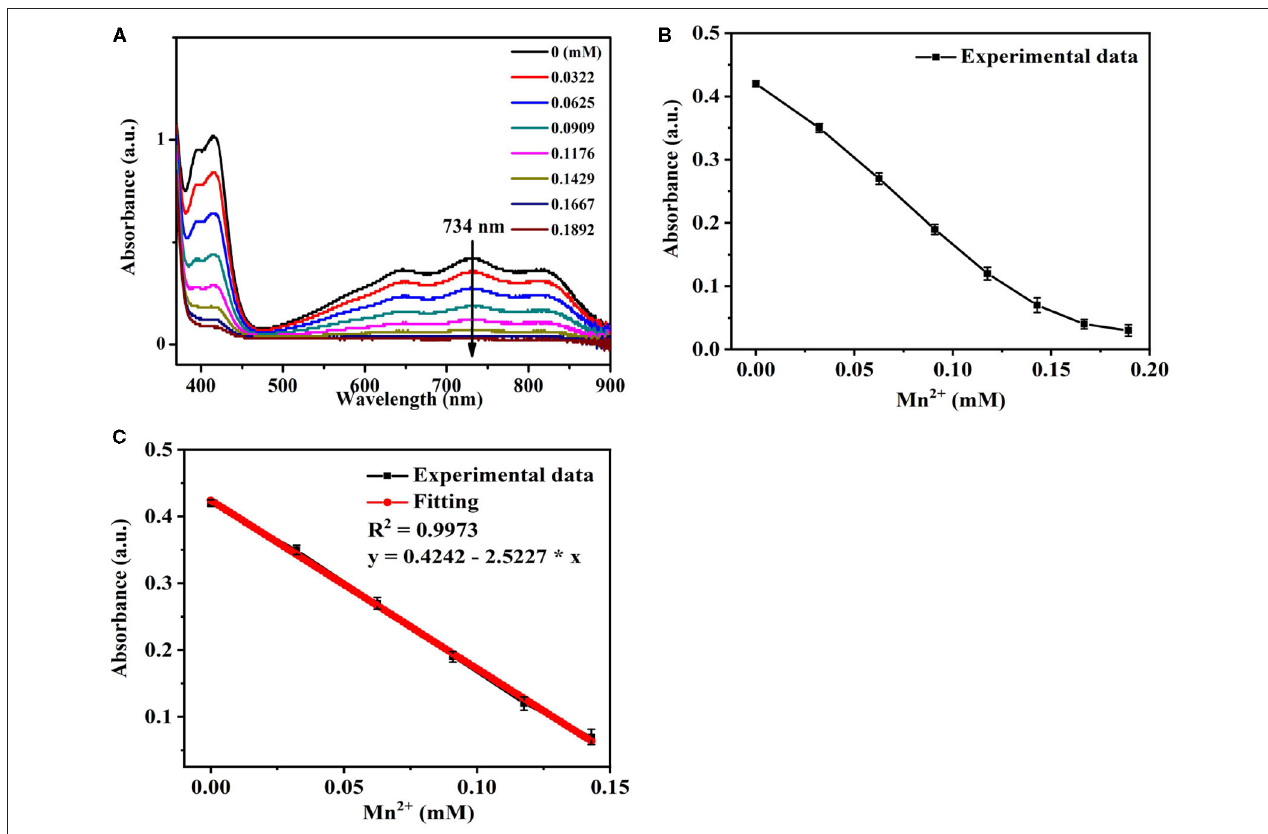
Figure 4 | (A) The UV-Vis absorption spectra of Se/N-CQDs + ABTS •+ mixed solutions (Mixed solutions) in the presence of different concentrations of Mn(II). (B) The UV-Vis absorbance of Mixed solutions in the presence of different concentrations of Mn(II) in the range of 0 to 189.20 µ M at 734nm. (C) The linear relationship between the UV-Vis absorbance of Mixed solutions and the concentrations of Mn(II) in the range of 0 to 142.90 µ M at 734nm.